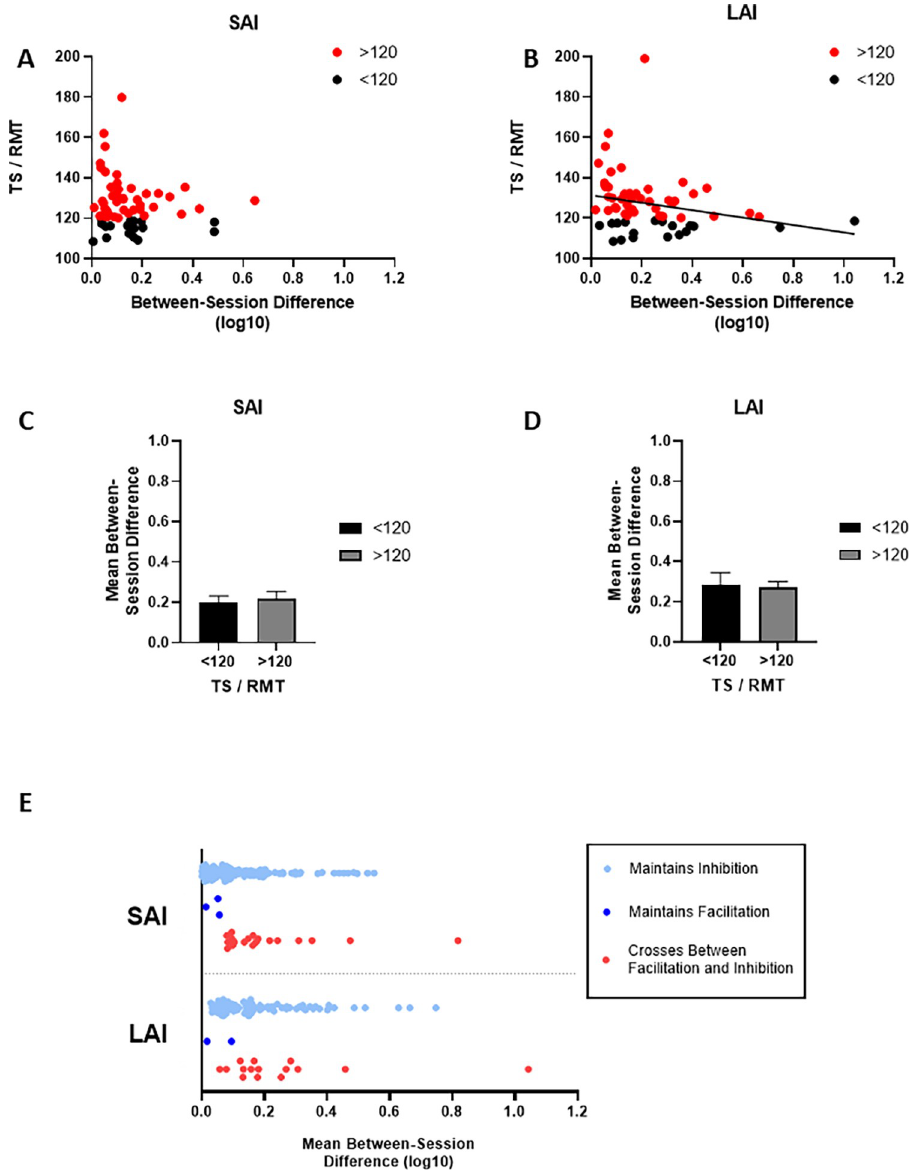
Fig 5. TS Intensity and inhibition-facilitation fluctuations. Panel A and B show the association between test stimulus intensity and between-session differences for log-transformed SAI and LAI, respectively. In panel C and D, between-session differences when the mean TS intensity was > 120%RMT versus < 120%RMT is shown for SAI and LAI, respectively. Panel E shows between-session differences in log transformed SAI and LAI ratios, separated into cases where participants always exhibited inhibition (light blue), always showed facilitation (dark blue), or crossed between inhibition and facilitation (red). Participants from Study E and F, who were assessed at multiple ISIs for SAI and/or LAI appear on the plot once for each assessed